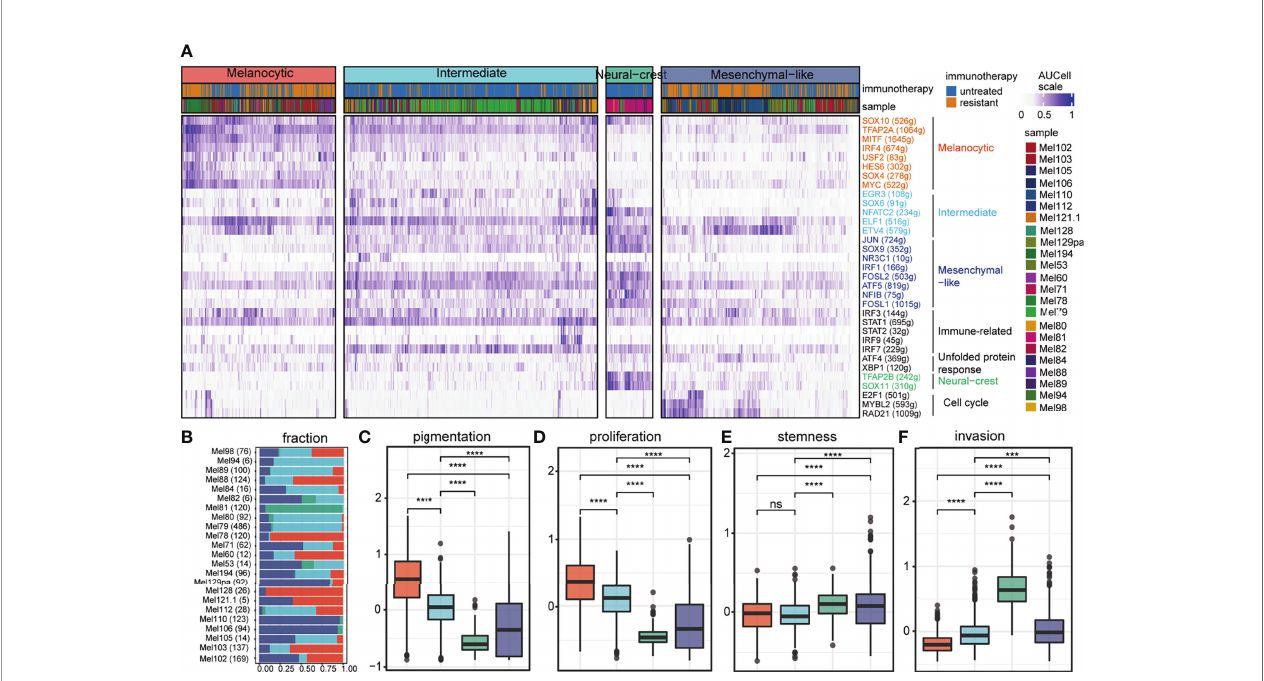
FIGURE 1 | Inferred cell states of tumor cells from SKCM patients. (A) Unsupervised clustering results of 2,018 tumor cells (samples n = 23) based on regulon activity pro fi les, including 4 clusters annotated by different colors. For each TF (rows), the number of genes contained in its regulon is shown in parentheses and its cell state speci fi city is indicated by color. (B) The composition of tumor cell states in each sample, where the number of cells contained in the sample is shown in parentheses on each row. (C-F) The functional differences between the 4 tumor states are shown in the box diagram, including pigmentation shown in (C) , proliferation shown in (D) , stemness shown in (E) , and invasion shown in (F) . ns denoted non-signi fi cant, *** denoted p < 0.001, and **** denoted p <